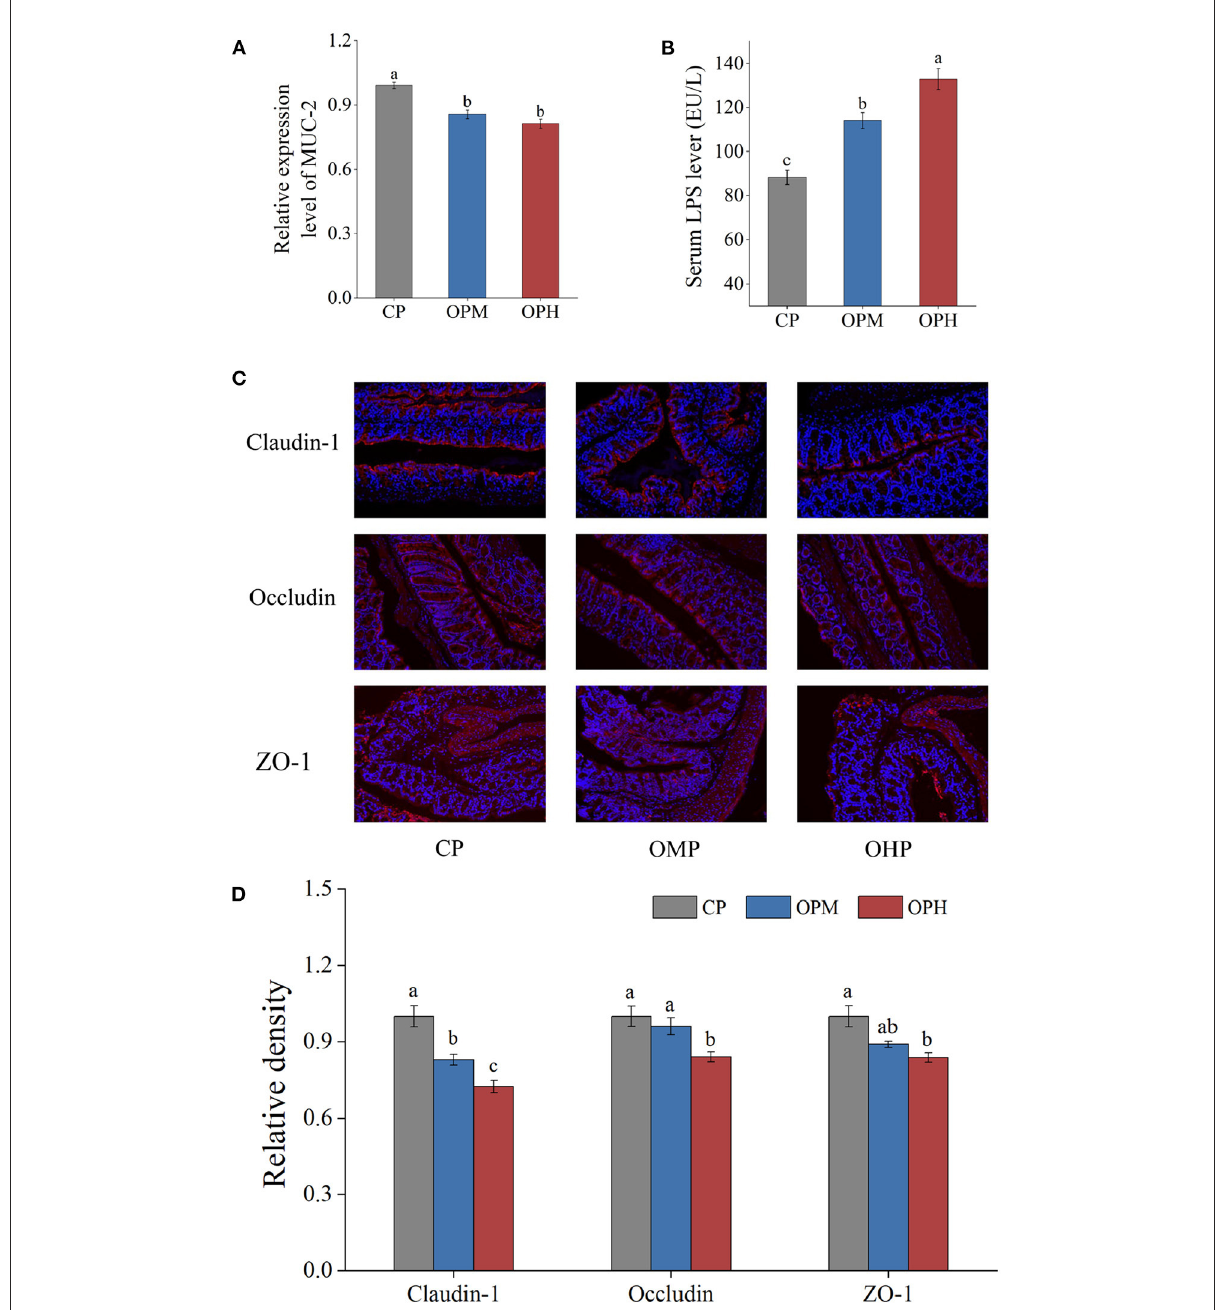
FIGURE6 Effects of consuming oxidized beef protein on colonic barrier function. The mRNA expression of MUC-2 (A) , LPS content in serum (B) , representative images of immunofluorescence of claudin-1, occludin, and ZO-1, original magnifications: × 200 (C) , the relative density of claudin-1, occludin, and ZO-1 (D) . Different letters (a-c) represent significant differences ( p < 0.05). The results were expressed in means ± SEM ( n = 8).